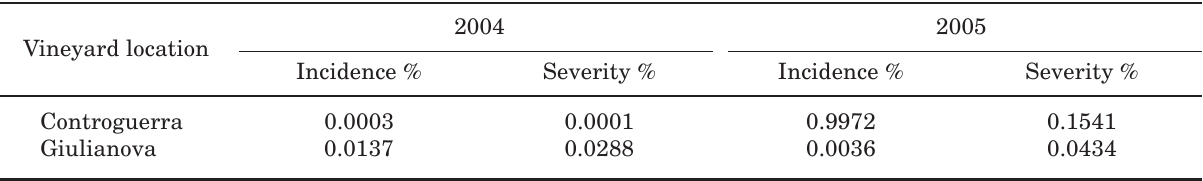
Table 6. Comparison of the incidence and severity of foliar symptoms between treated and untreated vines affected by esca proper according to the FREQ and CATMOD Procedure (SAS).